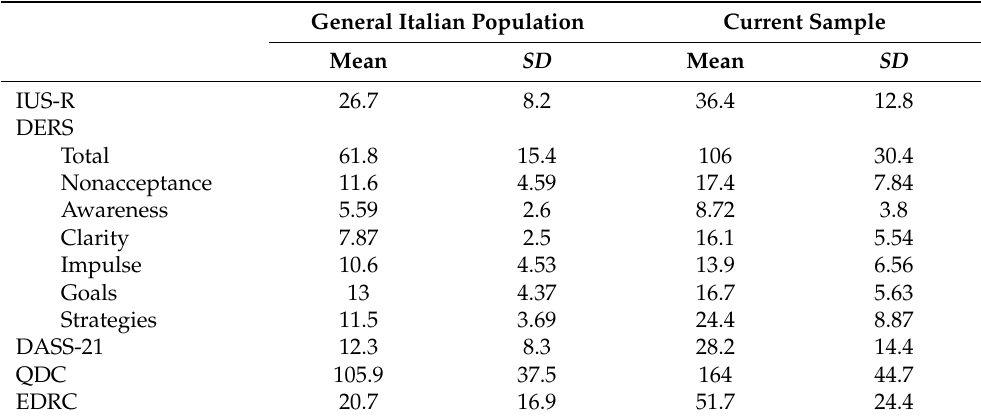
Table 2. Means and standard deviations for the Italian versions of the tools from published works (general population parameters) and the current sample. General Italian Population Current Sample Mean SD Mean